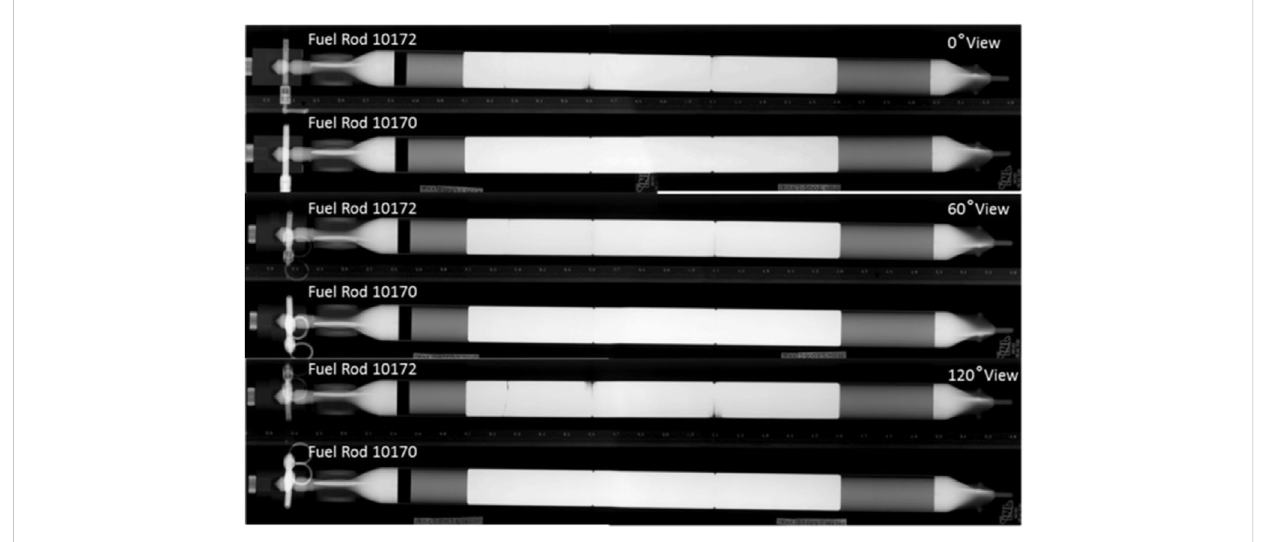
FIGURE 1 Thermal neutron radiographs for Fuel Rods 10172 and 10172 for the 0, 60- and 120-degree